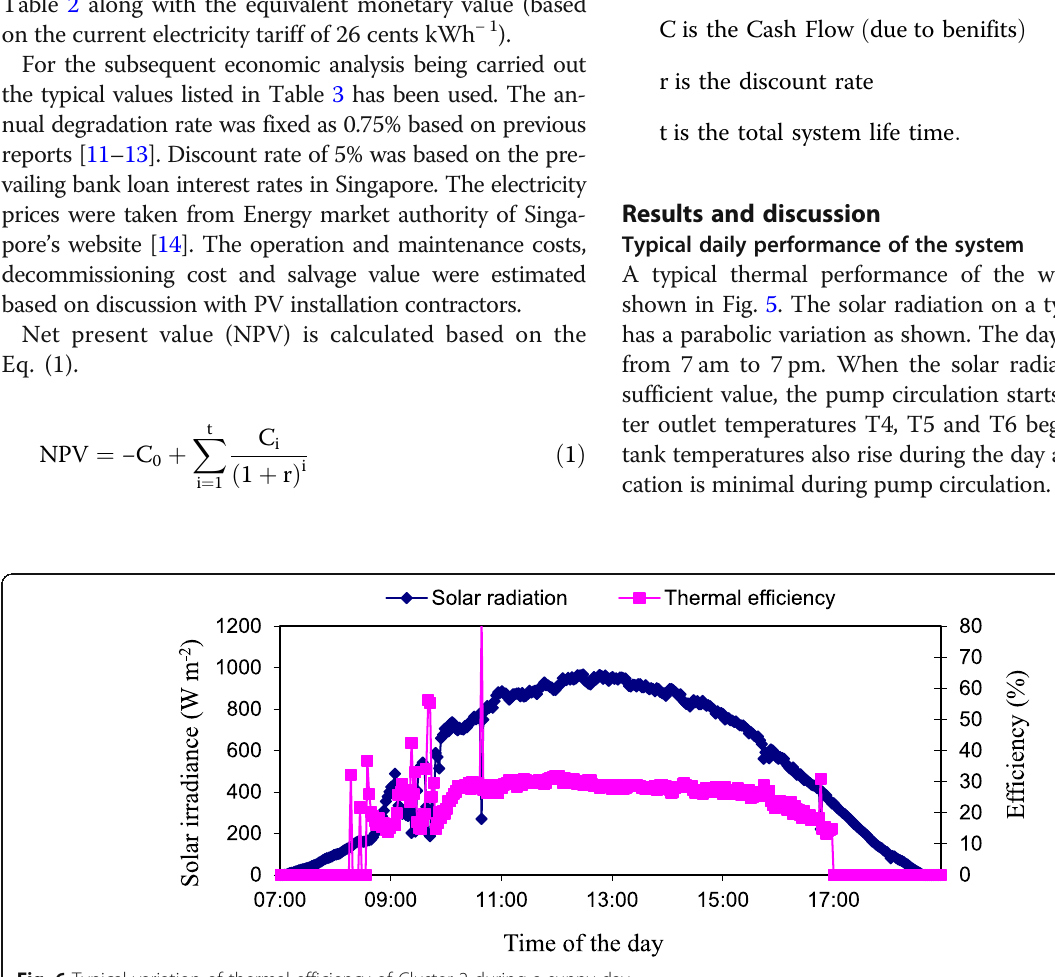
Table 2 along with the equivalent monetary value (based on the current electricity tariff of 26 cents kWh − 1 ).